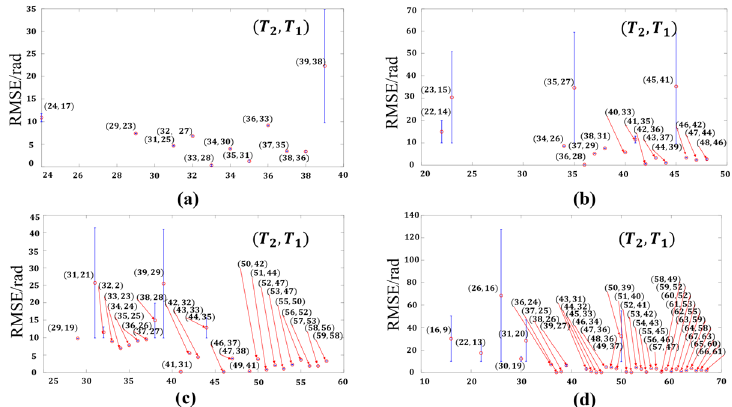
Figure 9. Error bar graph of Φ 123 s for various period combinations. ( a ) T 3 = 40, ( b ) T 3 = 50, ( c ) T 3 = 60, ( d ) T 3 = 70.